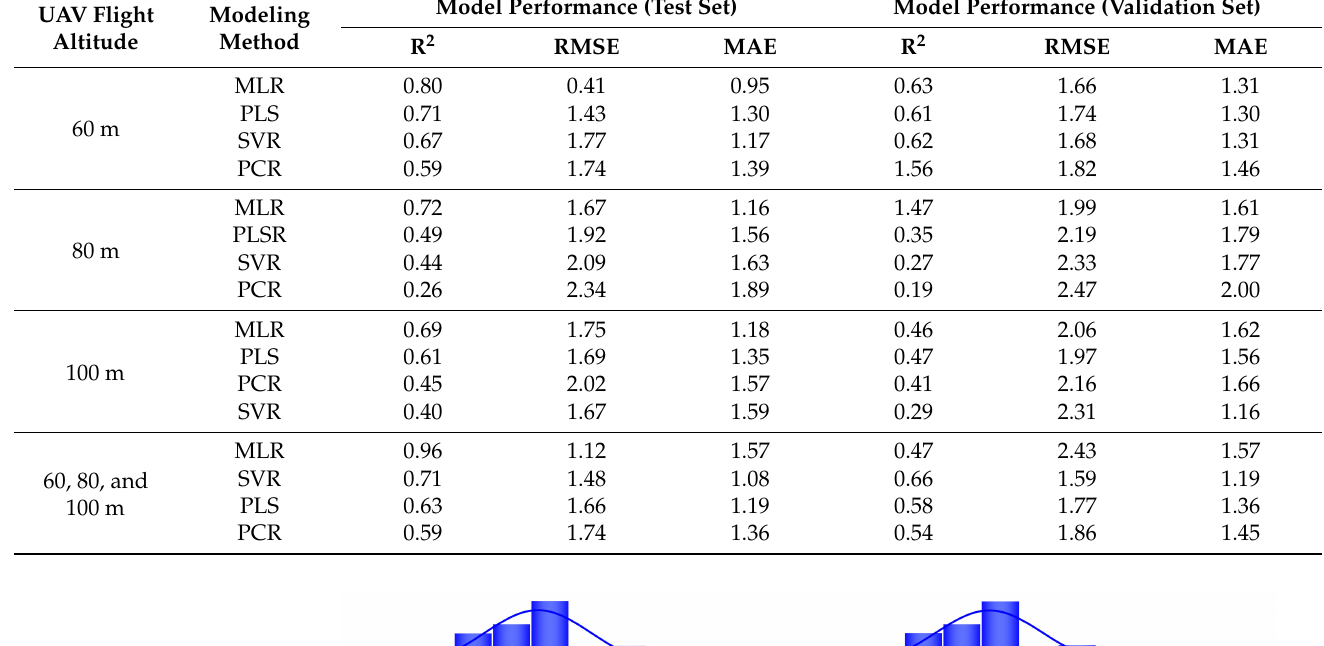
Table 3. The final results of modeling.